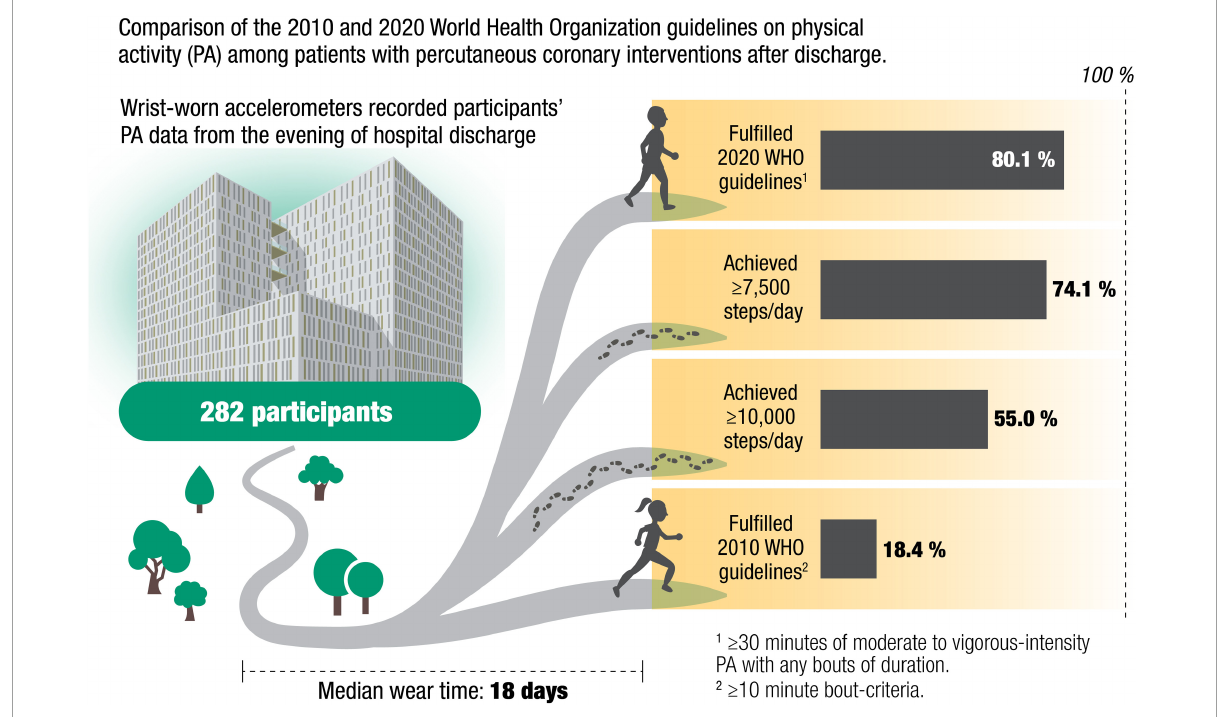
FIGURE4 Illustration of fraction of patients reaching 2020 versus 2010 World Health Organization guidelines on physical activity, as well as those reaching 7,500 and 10,000 steps per day.